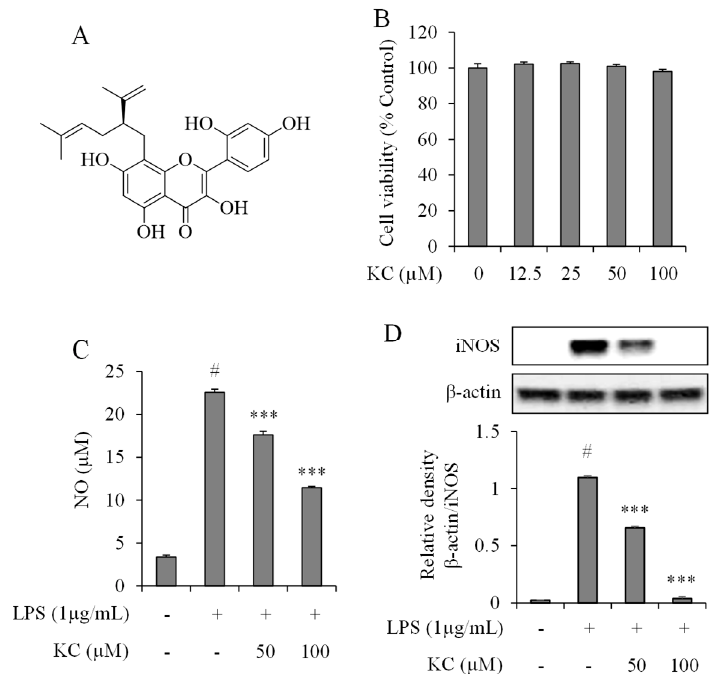
Figure 1. The chemical structure of kushenol C ( A ), and the effects of kushenol C (KC) on cell viability ( B ), NO production ( C ), and iNOS expression levels ( D ) in LPS-stimulated RAW264.7 macrophages. ( B ) RAW264.7 cells were treated with KC (0, 12.5, 25, 50, or 100 µ M) for 24 h, and the relative cell viability was assessed by WST-1 assay. ( C ) RAW264.7 cells were pretreated with KC (50 or 100 µ M) and stimulated with LPS (1 µ g / mL). The culture supernatant was subjected to a nitrite assay. ( D ) The iNOS expression levels were determined by western blot analysis of total protein extract. Error bars represent the means ± SDs, # p < 0.001 vs. control, *** p < 0.001 vs. LPS-only treated cells.